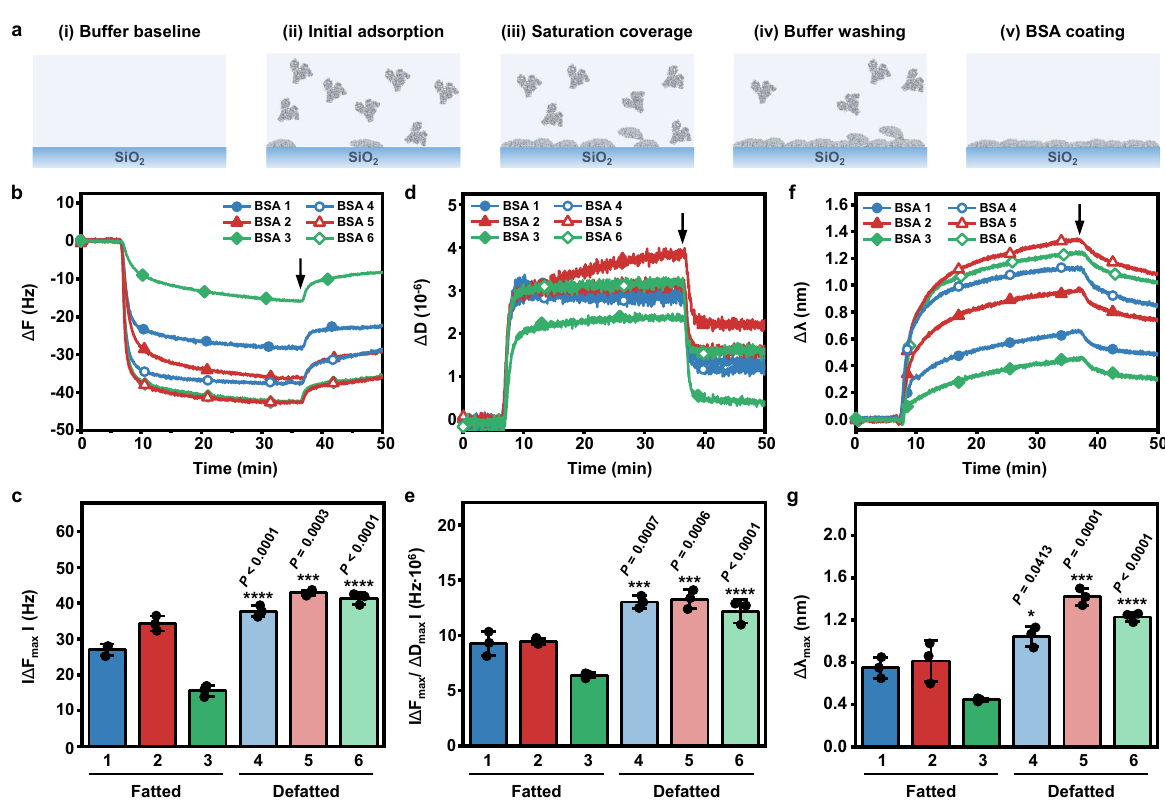
Fig. 3 Real-time monitoring of BSA protein adsorption onto fl at and nanostructured silica surfaces. a Overview of experimental protocol. b – e QCM-D experiments tracking frequency ( Δ F) and energy dissipation ( Δ D) shifts related to BSA adsorption. b Time-resolved QCM-D Δ F shifts and ( c ), corresponding | Δ F max |shifts at saturation. d Time-resolved QCM-D Δ D shifts. e | Δ F max / Δ D max |ratios obtained from saturation data in panels b and d . f – g LSPR experiments were conducted to measure wavelength shifts ( Δ λ ) related to BSA adsorption. f Time-resolved LSPR Δ λ shifts and ( g ), corresponding Δ λ max shifts at saturation. Data in ( c , e , g ) are reported as mean±s.d. ( n = 3 biological replicates, one-way ANOVA with Tukey ’ s multiple comparisons test). P values are reported for defatted BSA proteins (versus fatted BSA proteins from the same fractionation method). Dots represent individual data points.